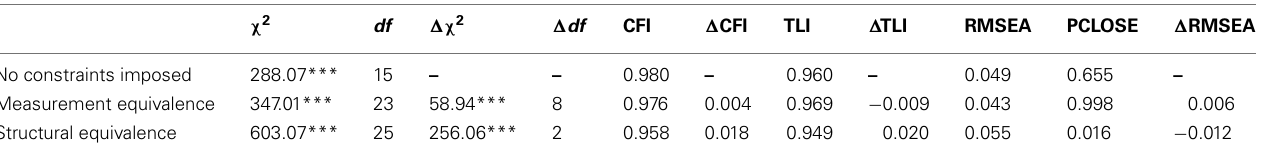
Table 2 |Tests for measurement and structural equivalence of the conspiracy mentality questionnaire across the three language versions (English, German,